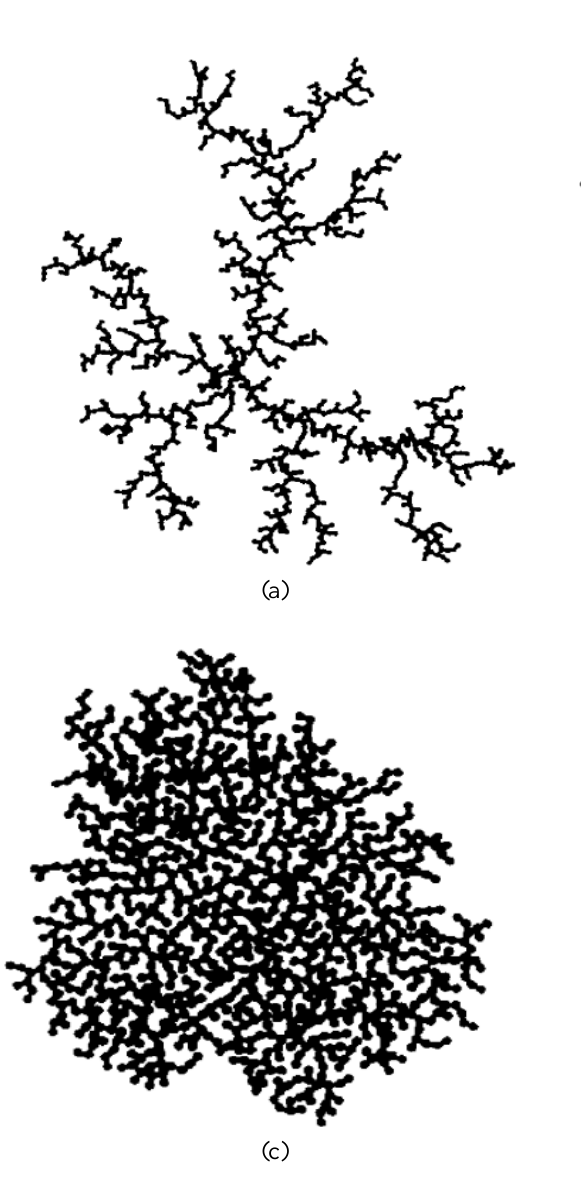
Fig. 1. Variant of visualization of model of micelle of k-casein according to HyperChem – public information.